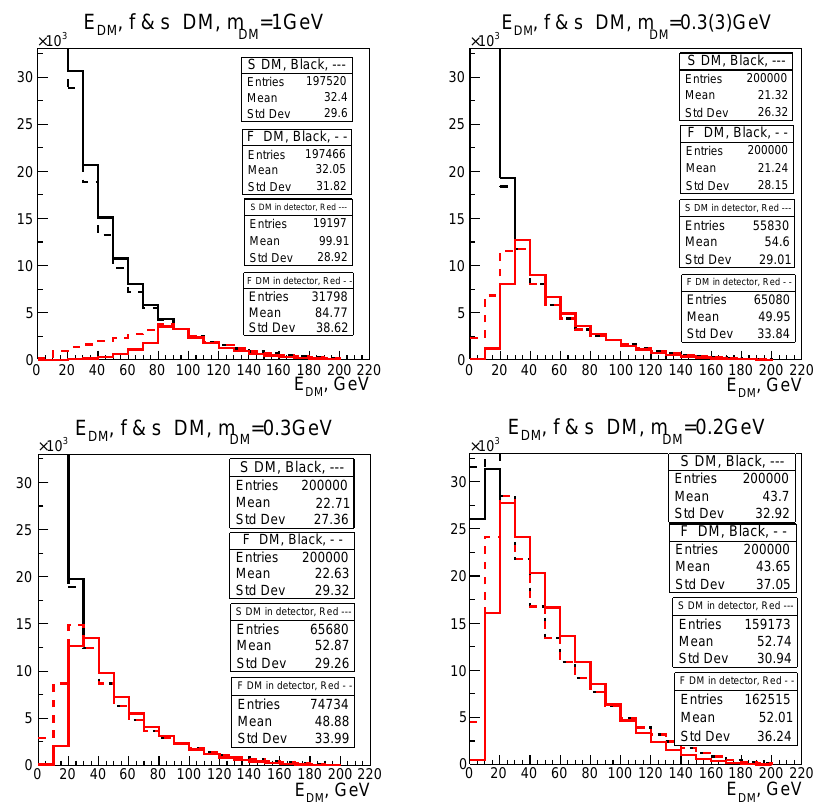
Figure 6. Energy E distributions of simulated LDM particles with various masses produced in the target and reaching the SND